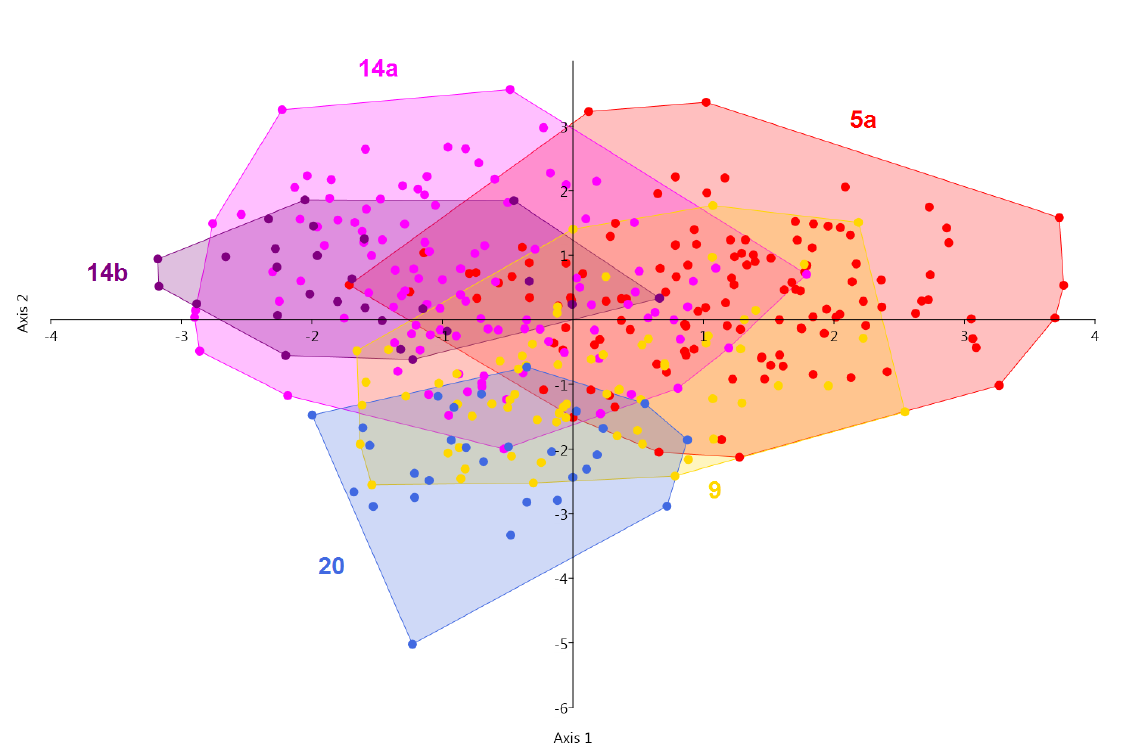
Fig. 3. DFA based on 11 counts and 2 coded characters as in Supp. file 4. Clade 5 = 5a, Danubian tributa- ries in Bulgaria (Nishava, Beli Vit, and Palakaria samples and P. csikii Hankó, 1922 from type locality). Clade 14 = non-Danubian rivers of the Black Sea coast in Bulgaria (14a, Izvorska, Veleka, Karaagach and Kamchiya) and Turkey (14b, Gönen and Sapanca). Clade 9 = P. marsilii Heckel, 1836. Clade 20 = Crimea, Salhir. DFA statistics values: Wilks’ Lambda 0.16694, approx. F (45.1345) = 14.709, p < 0.0000 (perfect